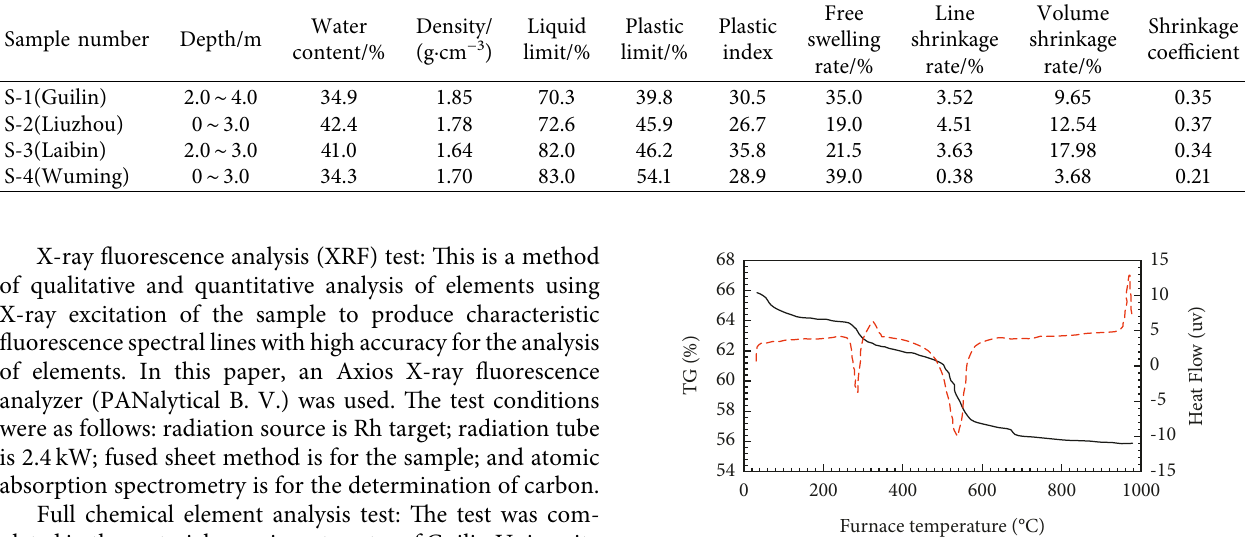
Table 1: Physical indices of soil samples